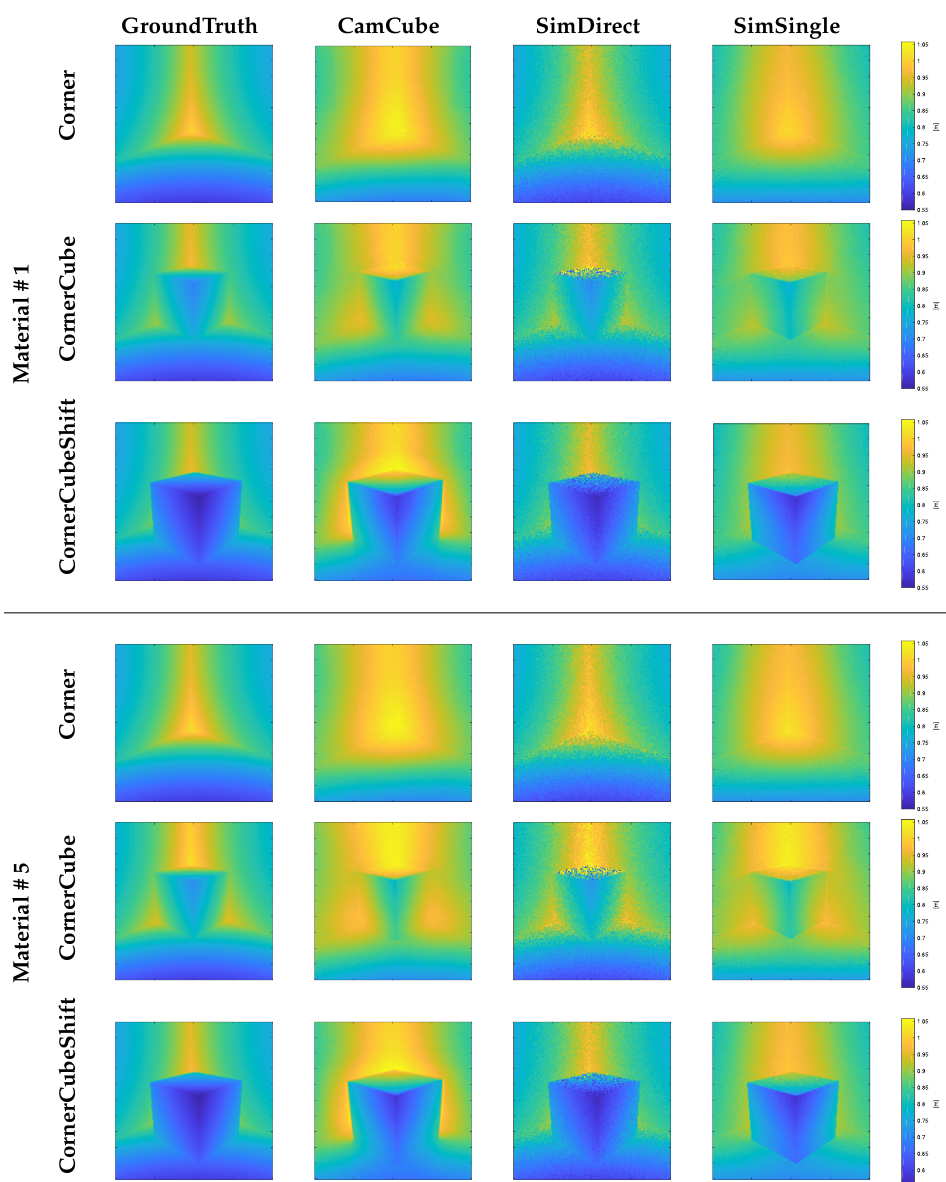
Figure 6. Range image comparison: GroundTruth (left) and CamCube (mid-left) compared with simulation using direct illumination ( SimDirect , mid-right) and single bounce reflection ( SimSingle , right) for the three test scenes Corner (row 1, 4), CornerCube (row 2, 5) and CornerCubeShift (row 3, 6) for Material # 1 and Material # 5 .